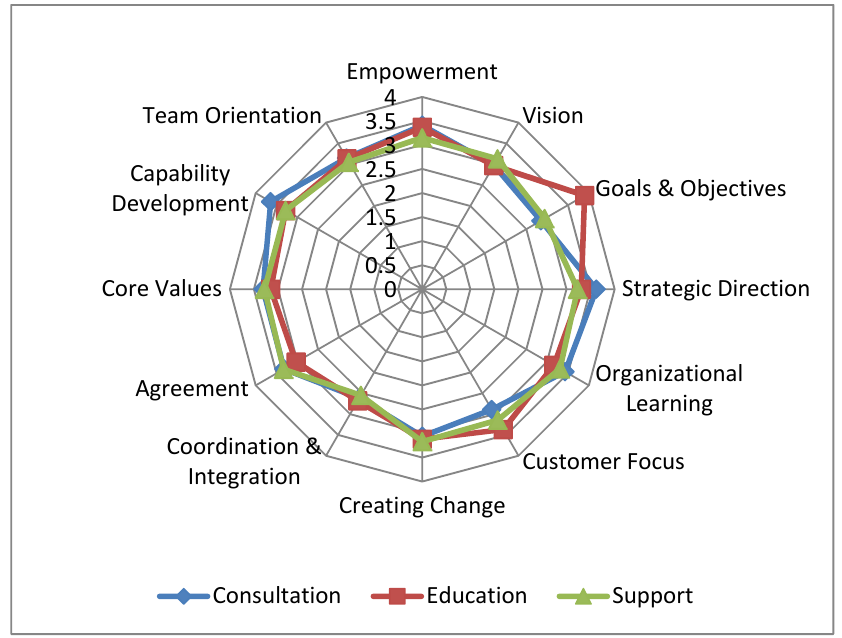
Fig. 4. The results of scores assigned to each component of the